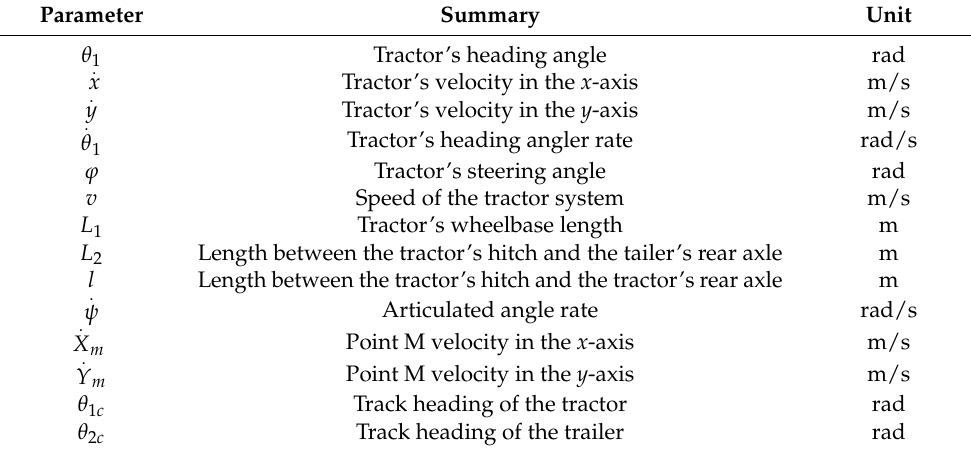
Table 1. Parameter